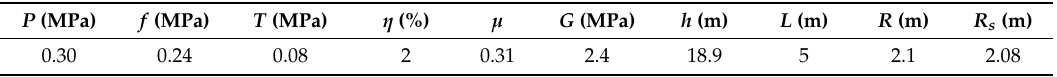
Table 1. Construction parameters for Line 1 and Line 3.